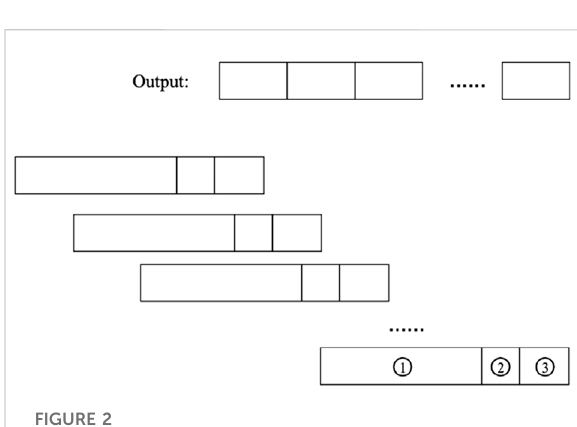
FIGURE 2 Sliding window operation mode. Note: the model performs estimation and prediction within one data window at a time, and after a single completion, lets the data window slide forward to performthesameestimationandpredictionoperationforthe next interval. Within each data window, we divide it into a ① training interval; ② a test interval and a ③ validation